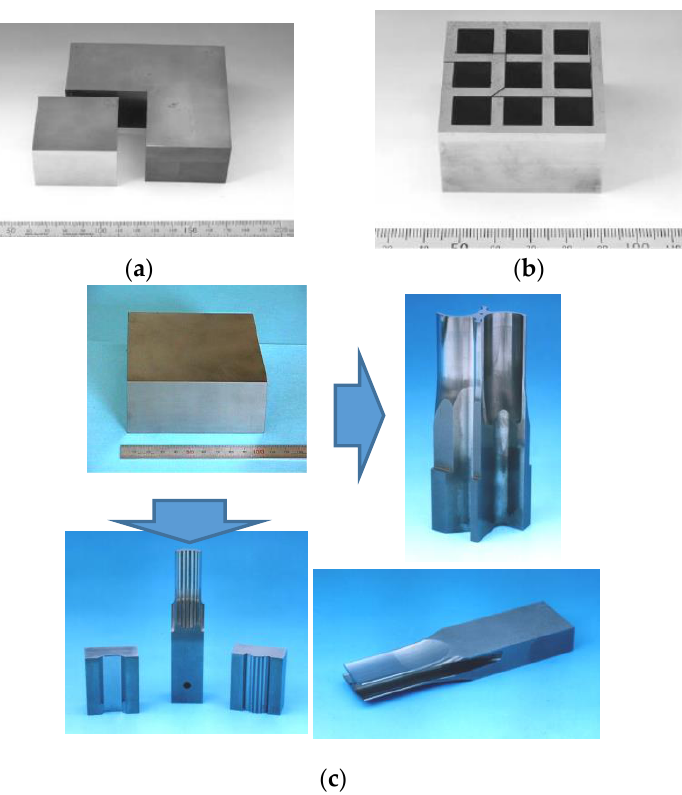
Figure 46. Example of press stamping die and punch made of WC/Co FGMs for electronic components: ( a ) single cut example by wire-cut EDM; ( b ) multi cut example by wire-cut EDM; ( c ) Examples of finished press stamping die and punches from large sized WC/Co FGMs material.